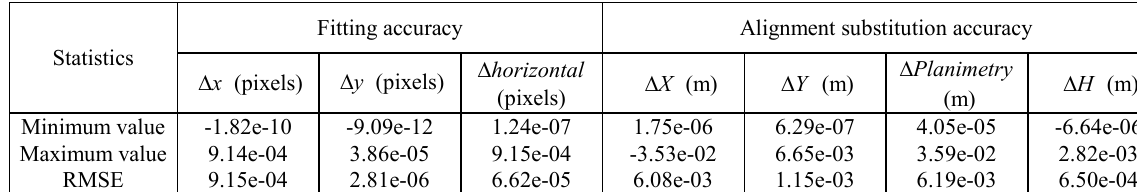
Table 1 . Fitting accuracy and alignment substitution accuracy of refining RFM.